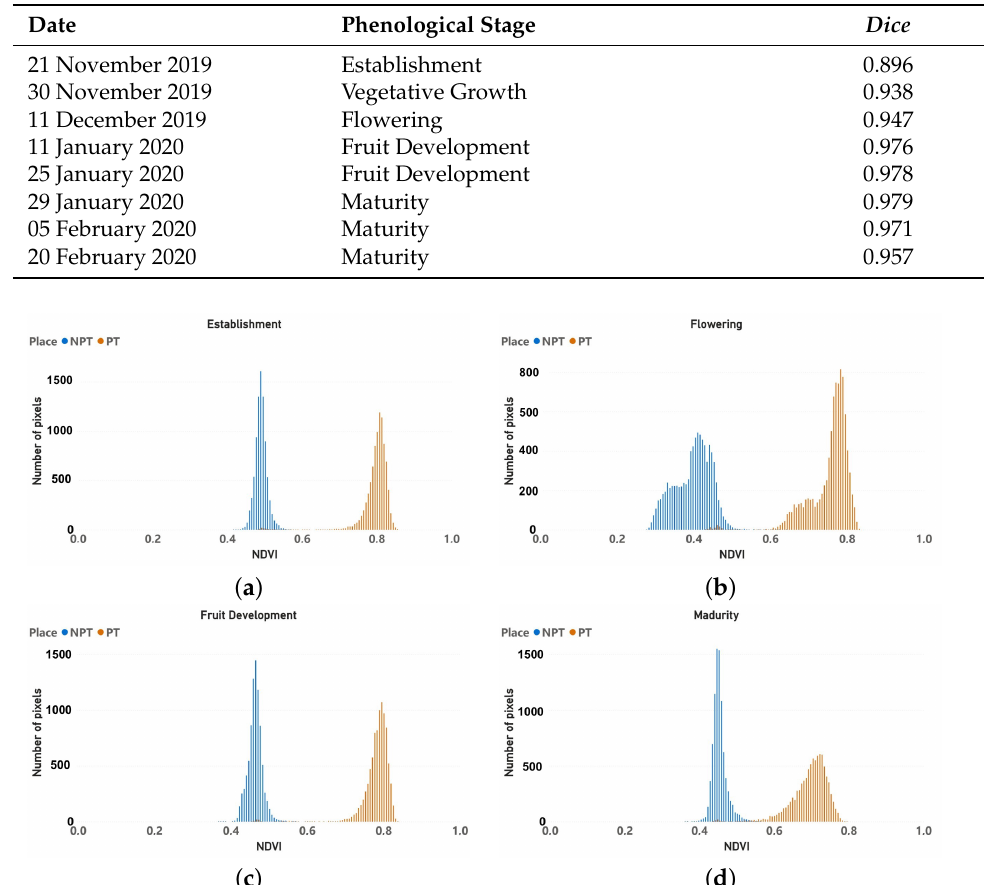
Figure 6. Histogram of NDVI maps segmented via SLIC for different tomato phenological conditions: ( a ) establishment (Vegetative growth) (30 November 2019); ( b ) flowering (11 December 2019); ( c )